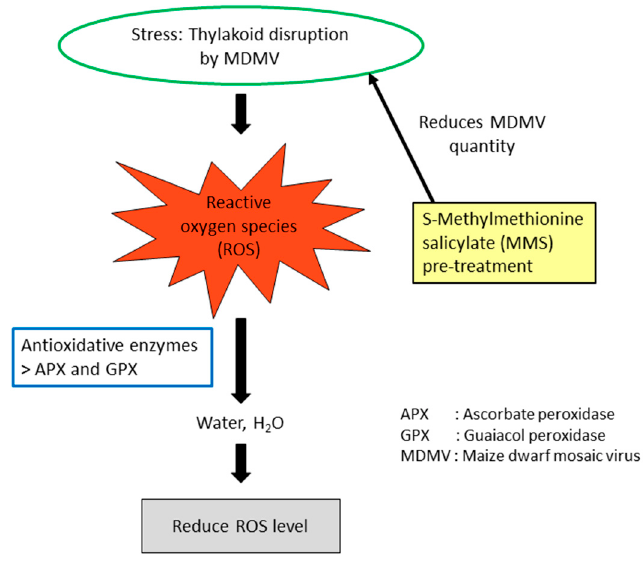
Figure 5. Role of S-Methylmethionine salicylate in the prevention of reactive oxygen species (ROS) development in corn plants.